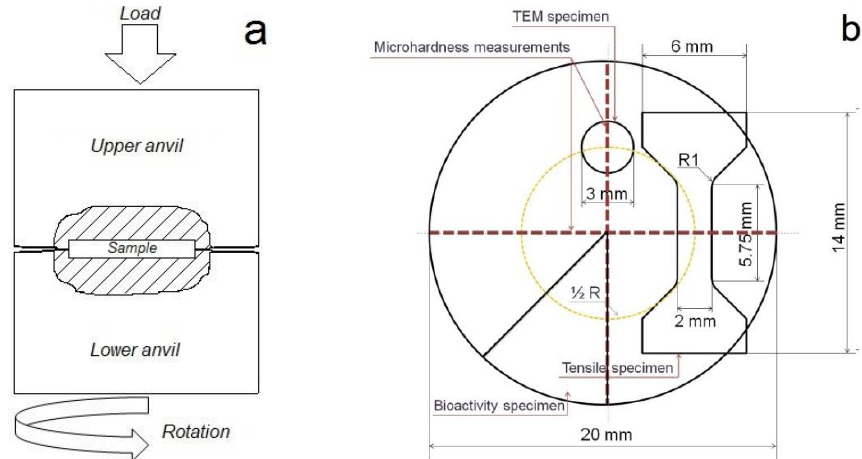
Figure 1. Schematics of the HPT process ( a ) and representation showing the locations for micro- hardness measurements on the HPT disc and the cutting position of TEM; bioactivity and tensile samples inside it ( b